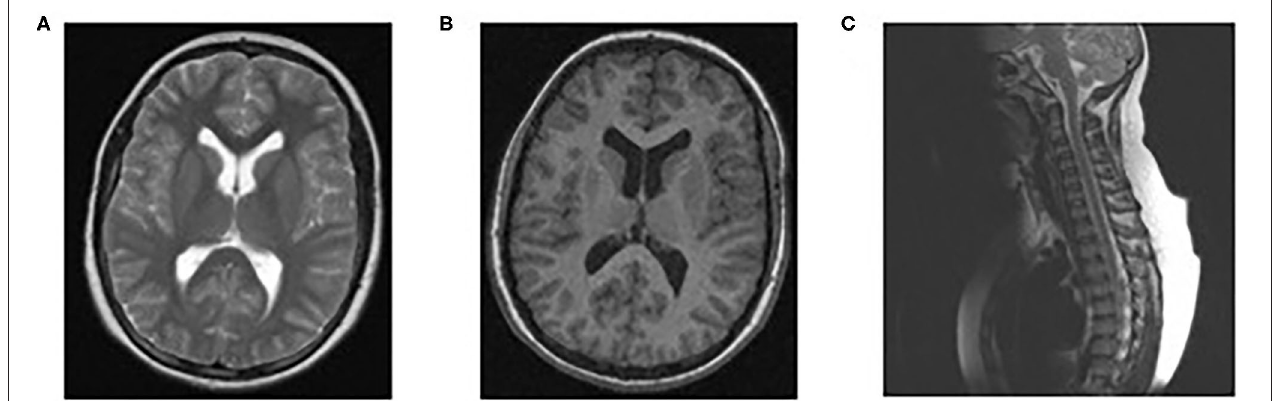
FIGURE 2 | Normal findings of brain/spinal MRI. MRI brain scan T1 (B) and T2 (A) , MRI spine sagittal (C)